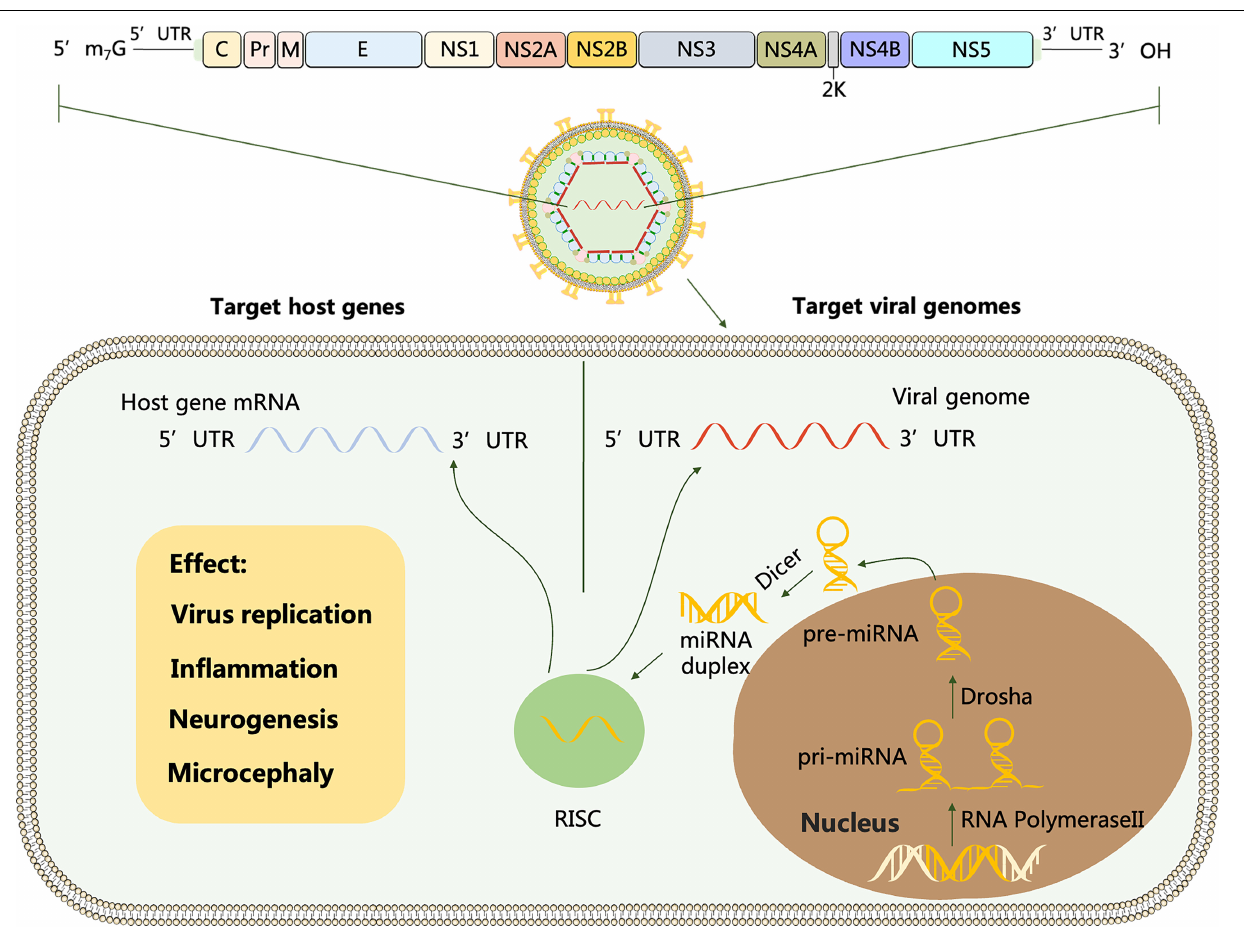
FIGURE 1 | Schematic representation of flavivirus genome. The polyprotein encoded by the genome is cleaved by host and viral proteases to form three structural proteins: capsid (C), membrane (M) and envelope (E) and 7 non-structural proteins (NS-1, 2A, 2B, 3, 4A, 4B and 5). miRNA is transcribed from host mRNA to primary miRNA (pri-miRNA) in the nucleus by RNA polymerase II (Pol II). Pre-miRNA is transported from the nucleus to the cytoplasm and cleaved by the Dicer enzyme into miRNA double strands, one of which forms an RNA-induced silencing complex (RISC). Target viral genomes: After flavivirus infection, the RNA viral genome releases into the cytoplasm, and RISC carrying miRNA complements the non-coding and coding sequences of the virus through miRNA seed sequences to regulate viral replication. Target host genes: After flavivirus invasion, miRNAs can activate or repress specific cellular signaling pathways and ultimately mediate viral replication by regulating the target genes they interact